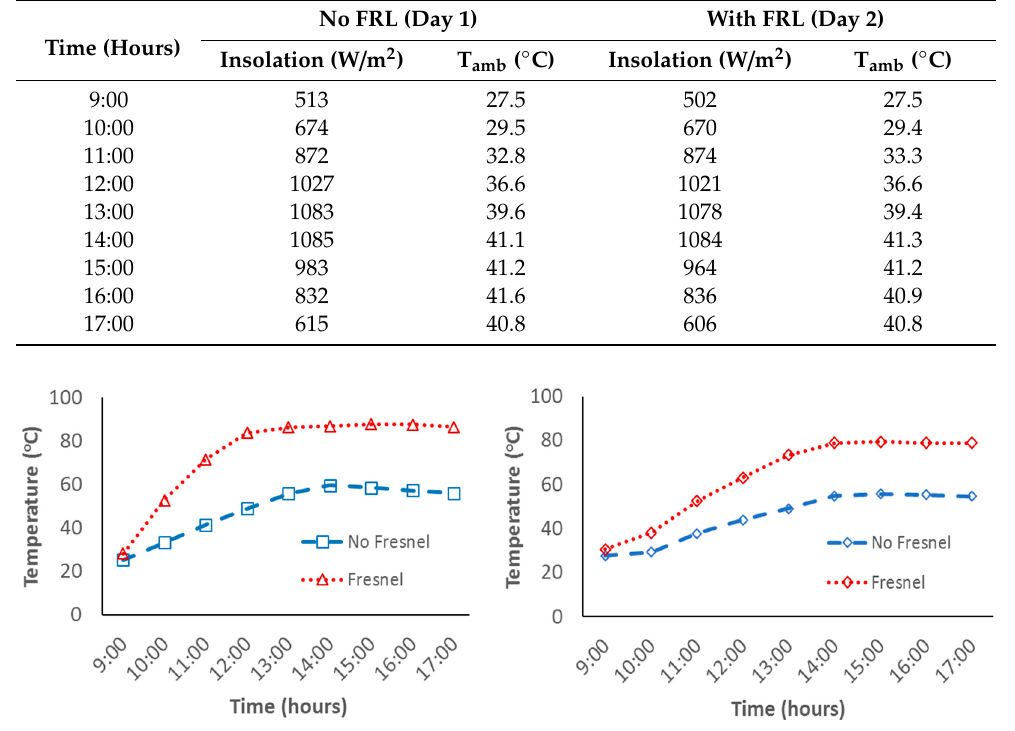
Table 3. Hourly variation of solar intensities, and ambient temperatures for experiments with and without FRL.